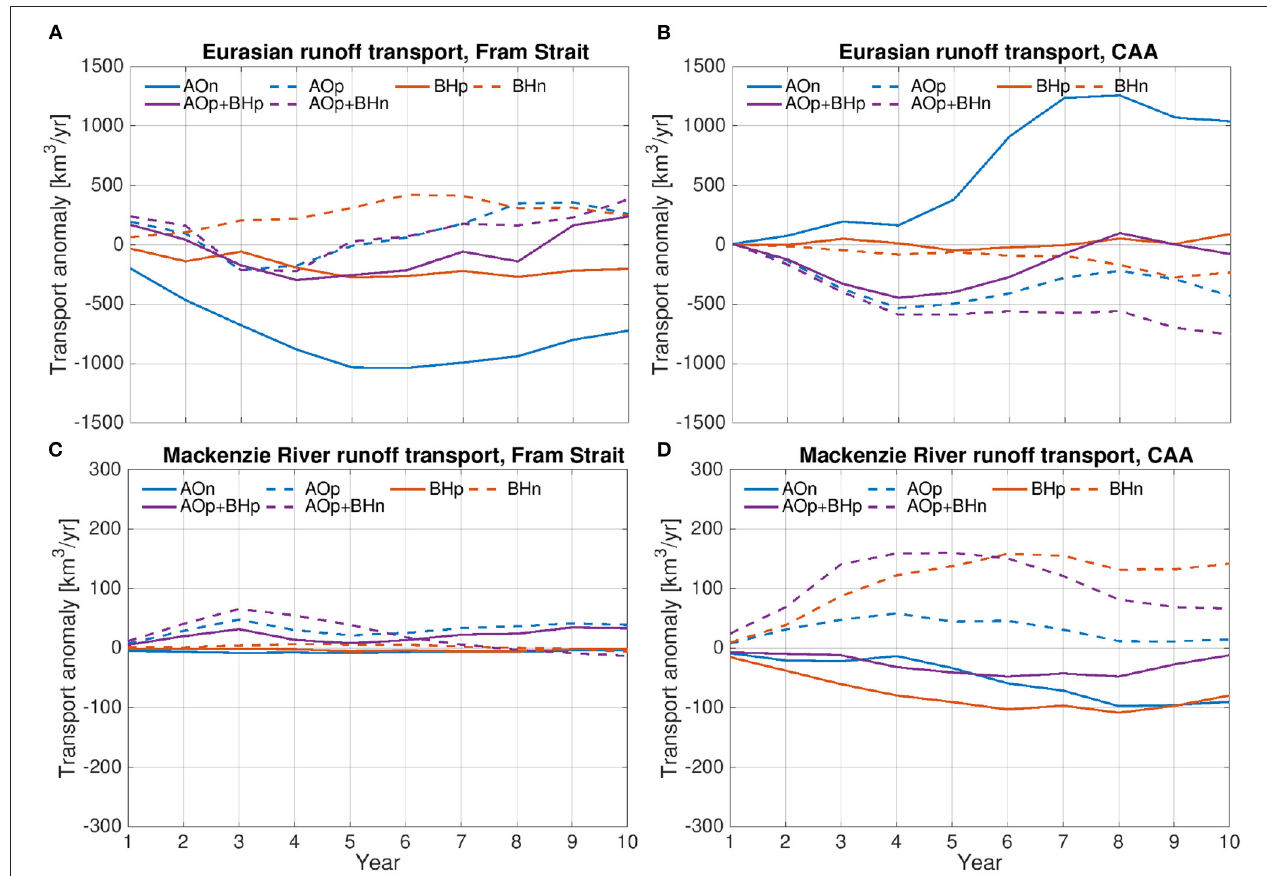
FIGURE 11 | Eurasian runoff volume export anomaly through (A) Fram Strait and (B) Canadian Arctic Archipelago (CAA). (C,D) The same as (A,B) , but for Mackenzie River runoff. The anomalies are relative to the control run. Positive values indicate larger export. Note that different y-axis scales are used in the upper and bottom rows.